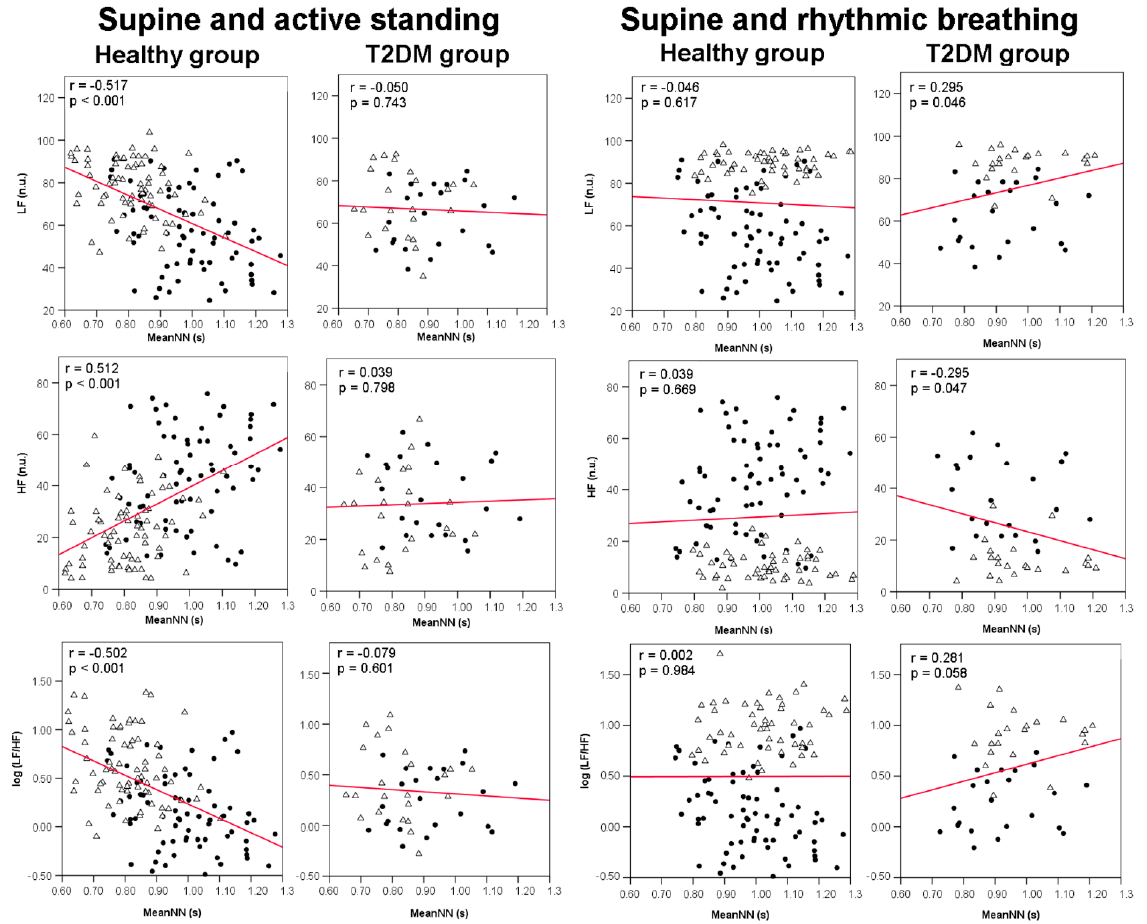
Figure 4. Dispersion plots between frequency domain HRV indices and meanNN in 44 healthy women (healthy group) and 19 female patients with type-2 diabetes mellitus (T2DM group). The plots on the left panels combine the HRV indices measured during both supine position (filled circles) and active standing (open triangles) of each group ( N = 88 for the healthy group and N = 38 for the T2DM group). The plots on the right panels combine the HRV indices measured during both supine position (filled circles) and rhythmic breathing (open triangles) of each group ( N = 88 for the healthy group and N = 38 for the T2DM group). MeanNN: mean value of all NN intervals; LF: low frequency band index; HF: high frequency band index; log (LF/HF): logarithm of the LF to HF ratio; n.u. = normalized units; r = Pearson’s correlation coefficient; p = p value.